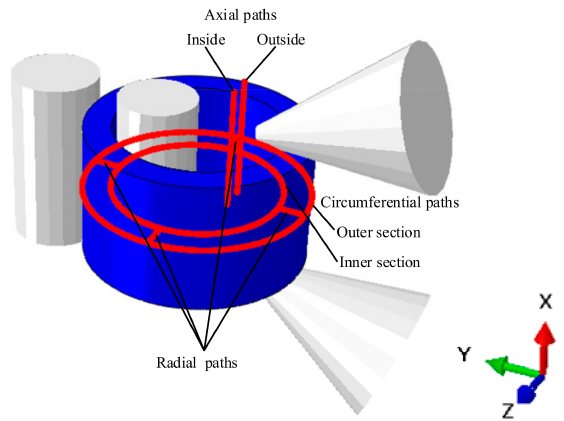
Figure 13. The axial, radial and circumferential paths.